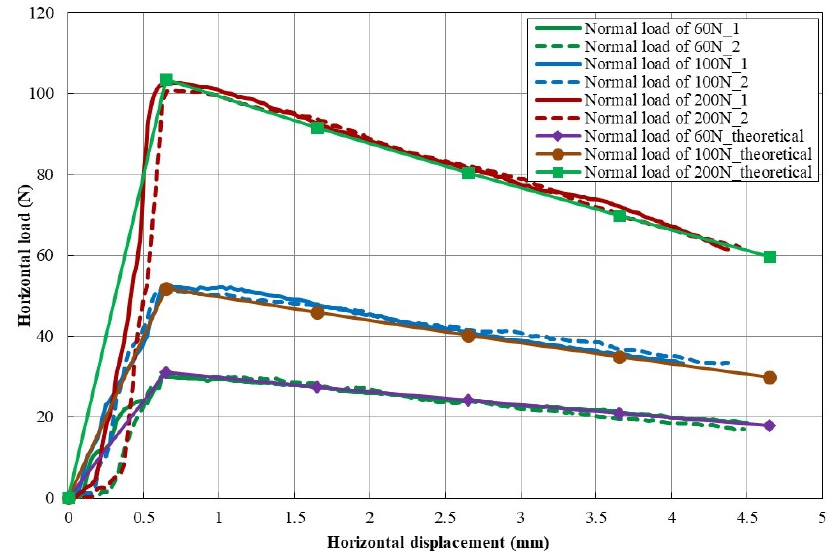
Figure 7. Comparison between measured and calculated horizontal forces based on the measured interparticle friction angle under the normal load of 60 N.